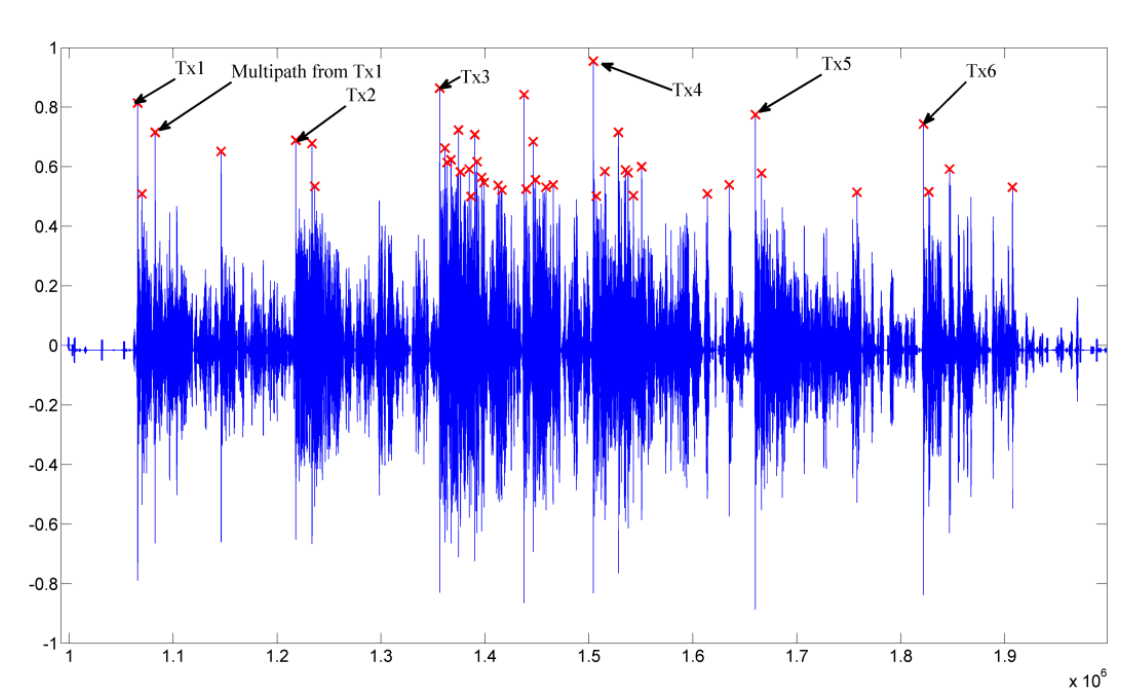
Figure 16. Correlation results of a complete LOSNUS sequence showing ToA for individual transmitters and an example for a Non Line of Sight (NLOS) signal for